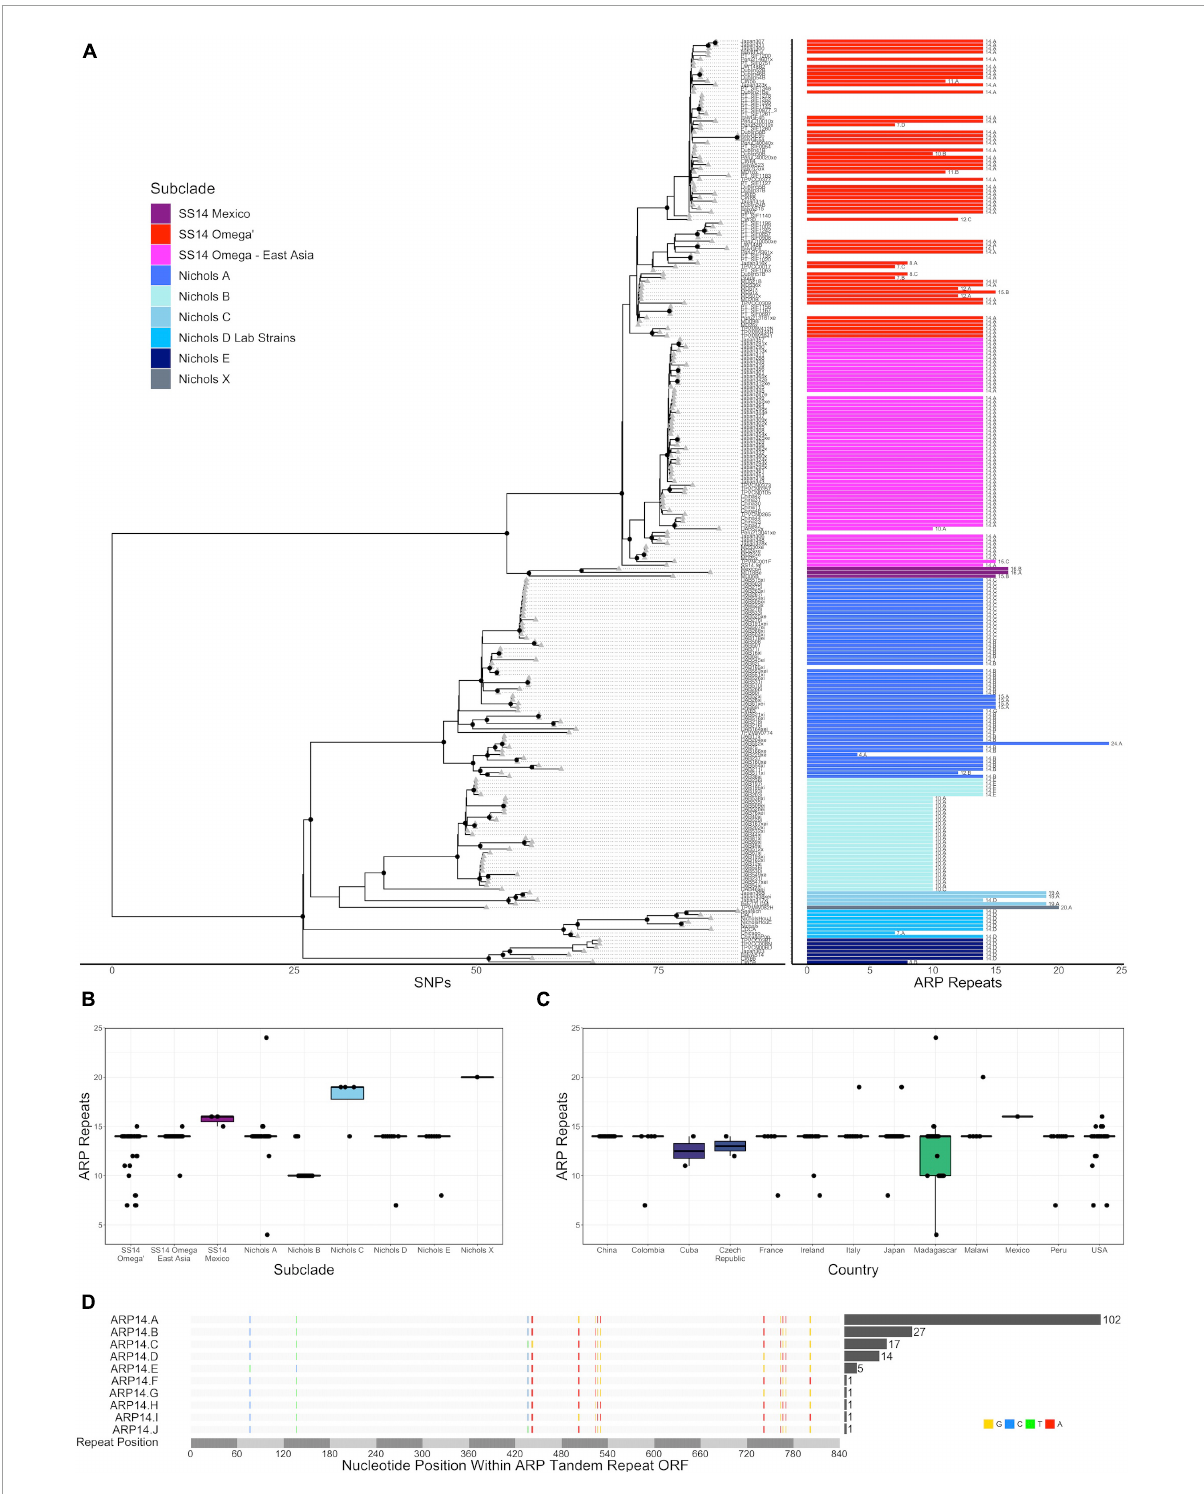
Supplementary Table 2 . Number of arp repeats by subclade (B) or country (C) . (D) Multiple sequence alignment of the nine variants with 14 arp repeats. Variant positions are highlighted and bases colored red, blue, yellow, or green for A, C, G, or T, respectively. The number of strains with each variant sequence is included in the bar graph to the right of the multiple sequence